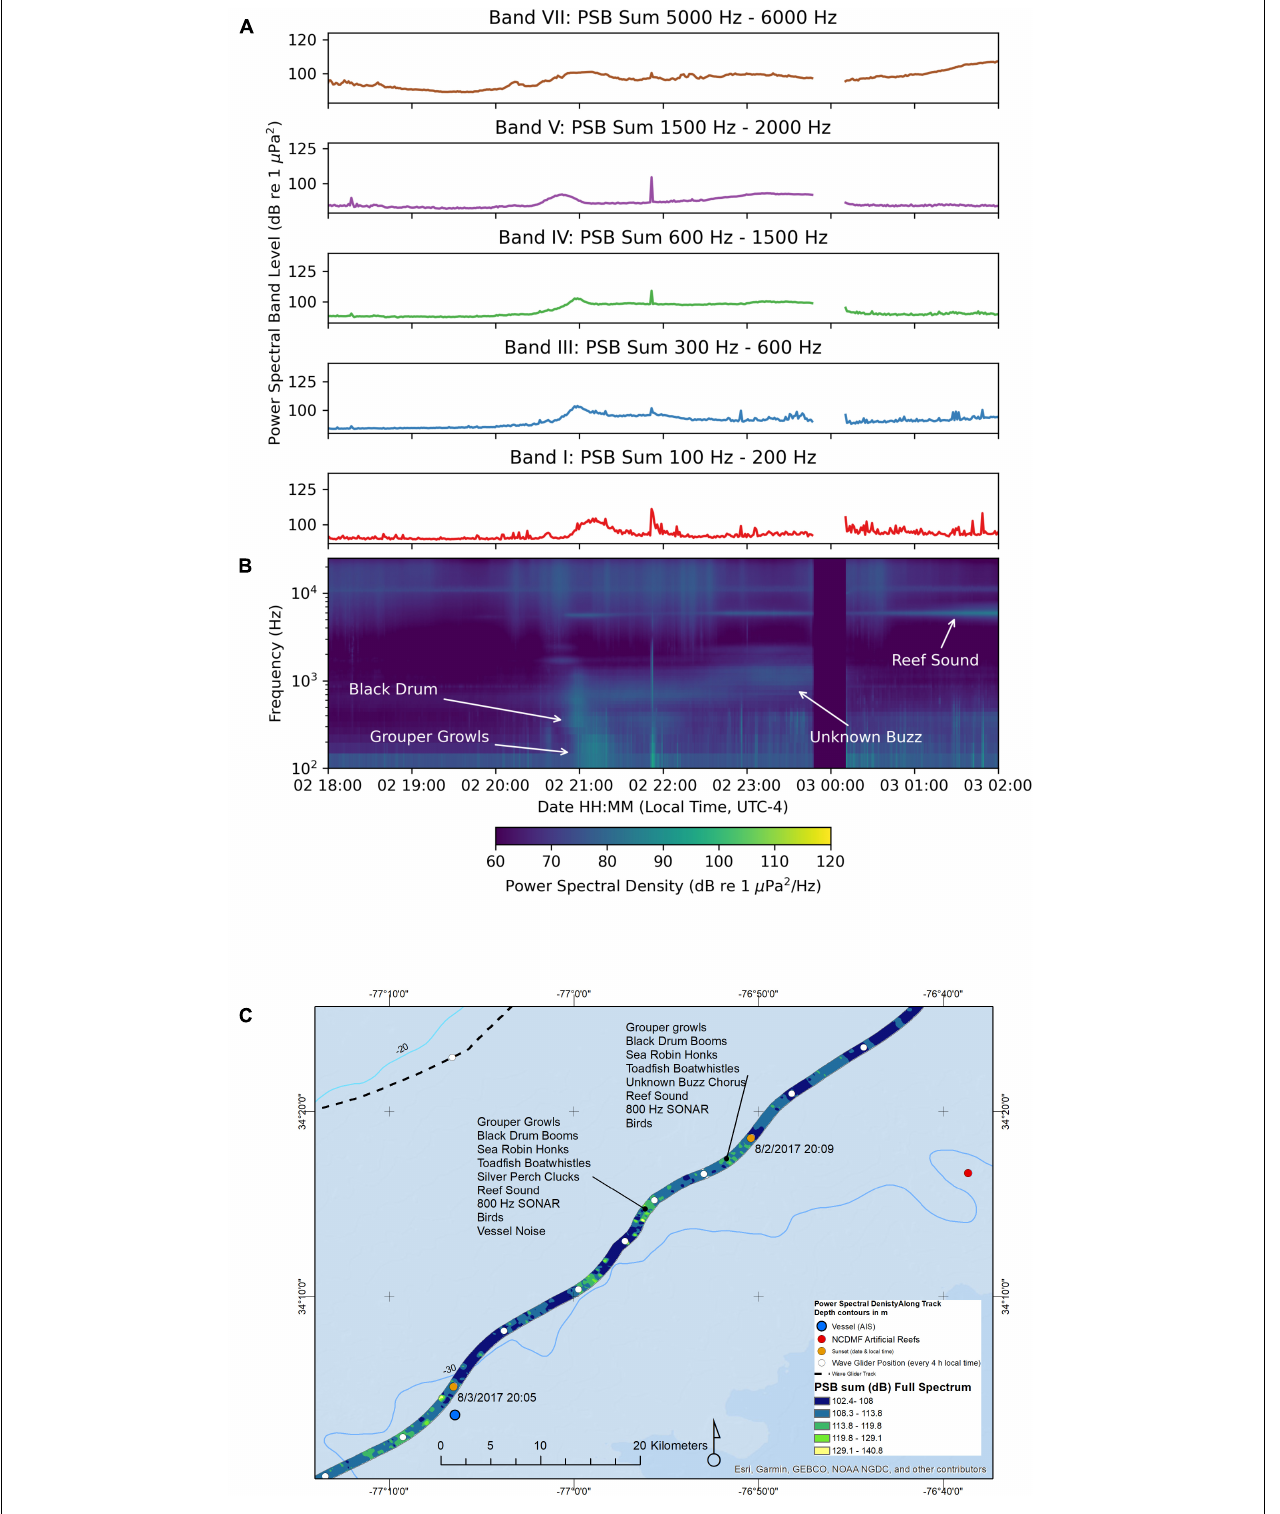
FIGURE 5 | Sound recorded by the wave glider Blackbeard between August-02 18:00 and August-03 0:00. (A) Power spectral band sums for 60 s windows of the recording. (B) Composite spectrogram produced from 60 s average power spectral densities. The gaps in the plots were due to the recording system being rebooted, and thus no data were obtained during this time. (C) Map of the path of the wave glider during the recording. The color of the path indicates the full spectrum PSB sum detected at the location.